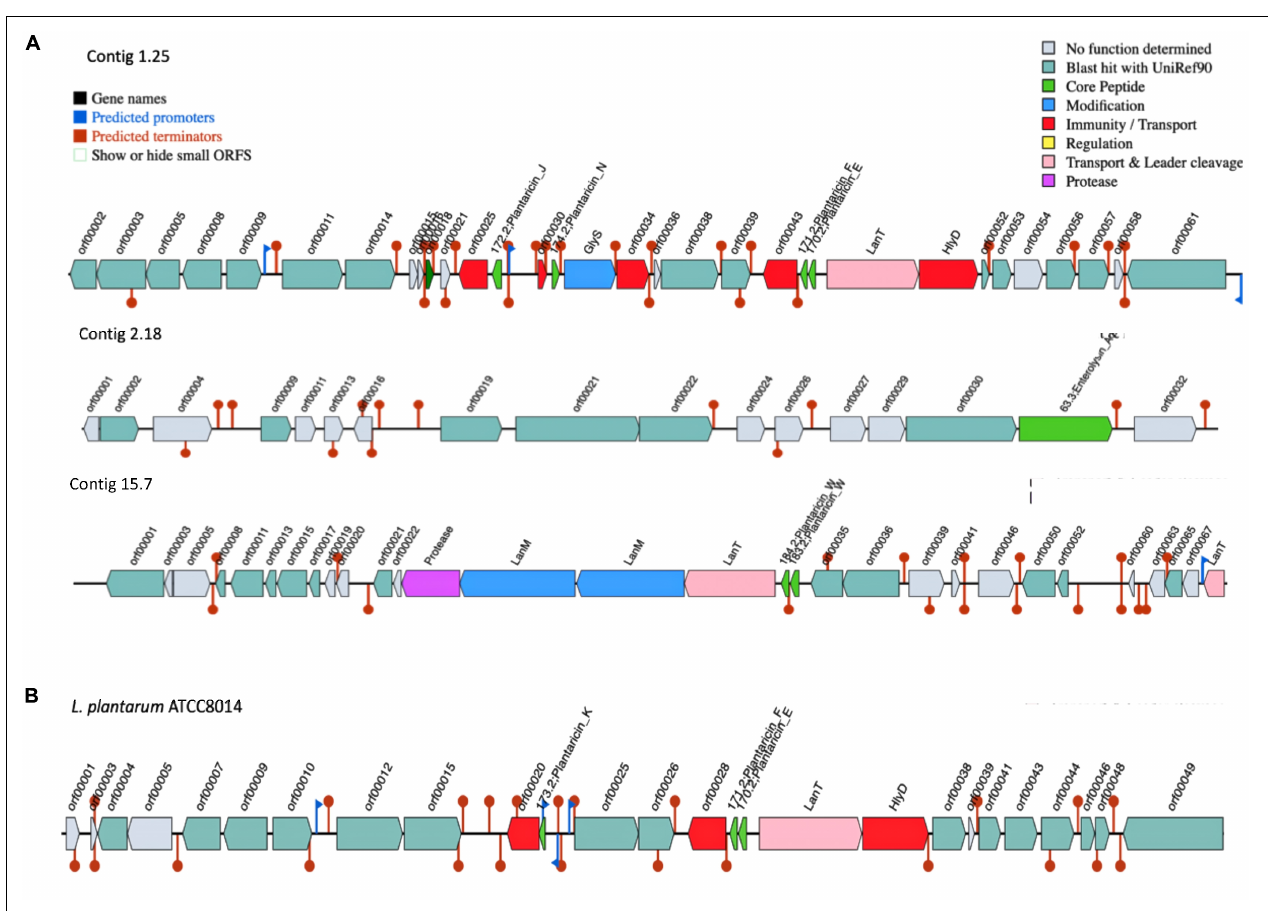
FIGURE 3 | BGCs organization. (A) L. plantarum UTNGt21A. (B) L. plantarum ATCC8014. Genes with function determined from left to right (gene name, function, and locus tag): contig 1.25: orf00018: ComC, bacteriocin Class II with double-glycine leader peptide; orf00025, putative bacteriocin immunity protein;